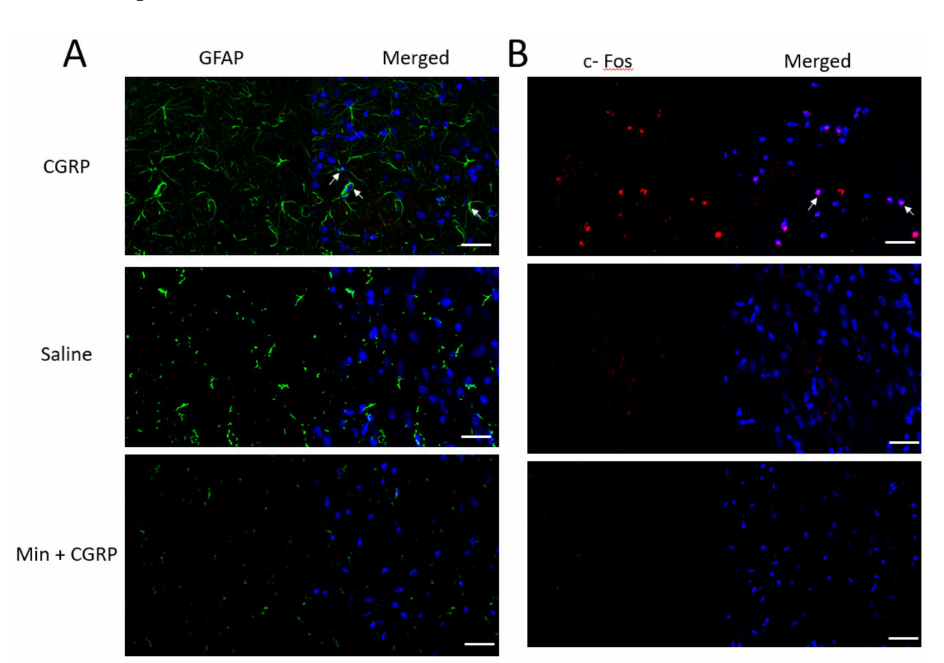
Figure 5. Following the administration of CGRP, Min + CGRP and saline in the TG the change in activity of neurons and astroglial cells in spinal trigeminal nucleus cells was qualitatively observed. Change in expression of glial fibrillary acidic protein (GFAP) in astrocytes, a marker of glial activation and neuronal c-Fos, an early immediate transcription factor and marker of second order sensory neurons in spinal trigeminal nucleus sections of spinal cord obtained from animals with IG administration of